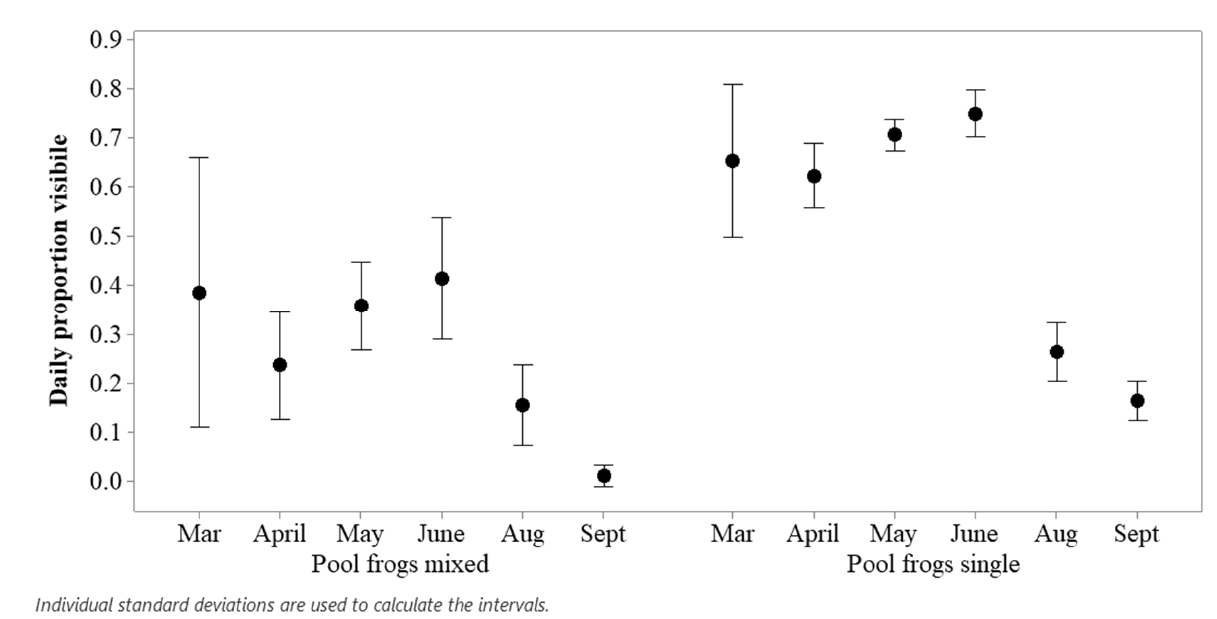
Figure 4. Interval plot of monthly sightings of pool frogs in two exhibits based on the proportion of the total number of potentially visible